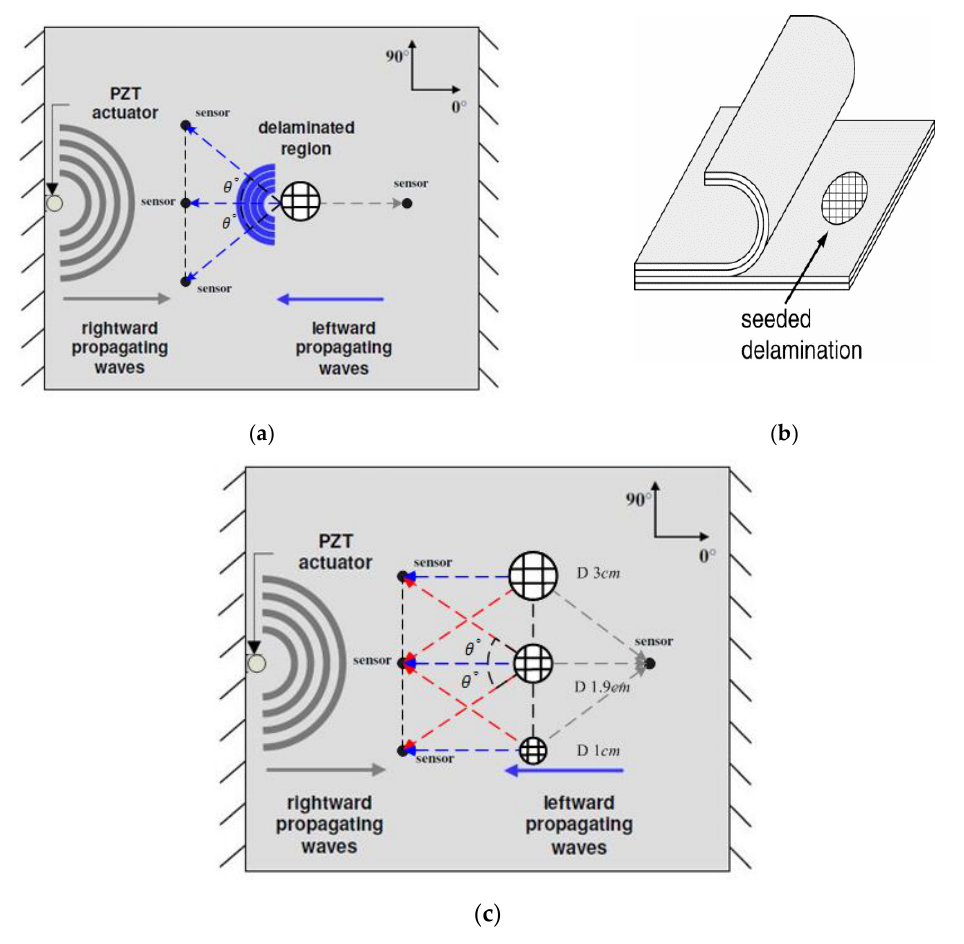
Figure 5. Experimental setups for the single and multiple damage inspections. ( a ) The inspection of single delamination in a CFRP specimen; ( b ) Teflon patches used to seed the delaminations; ( c ) The inspection of multiple delaminations in another CFRP specimen.